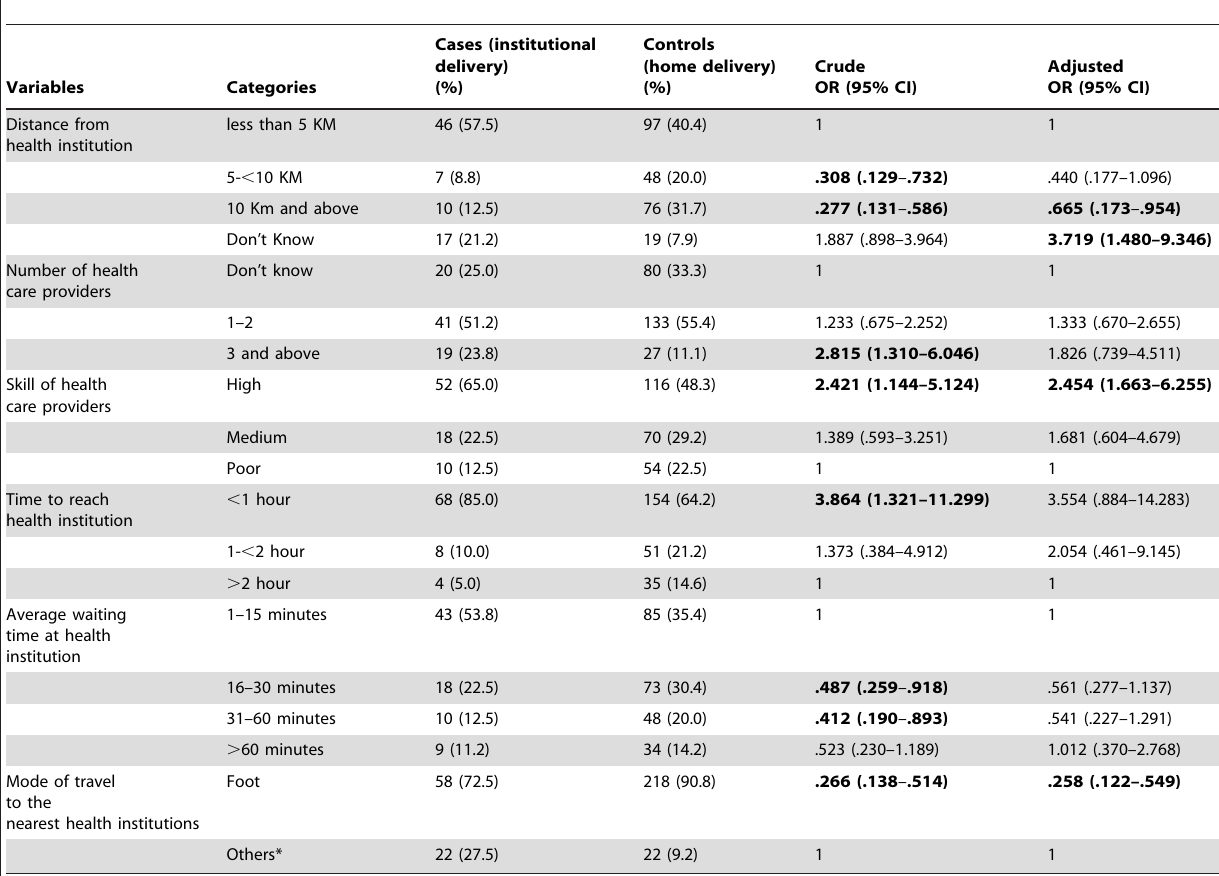
Table 4. Programmatic related determinant factors of institutional delivery in Western Ethiopia, October